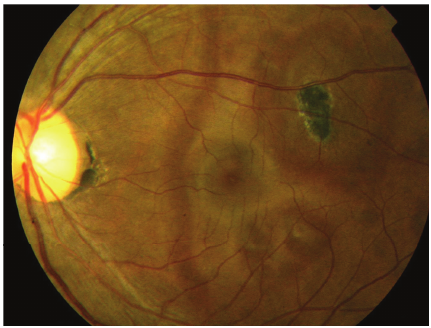
Figure 2: Color fundus photo (left eye).